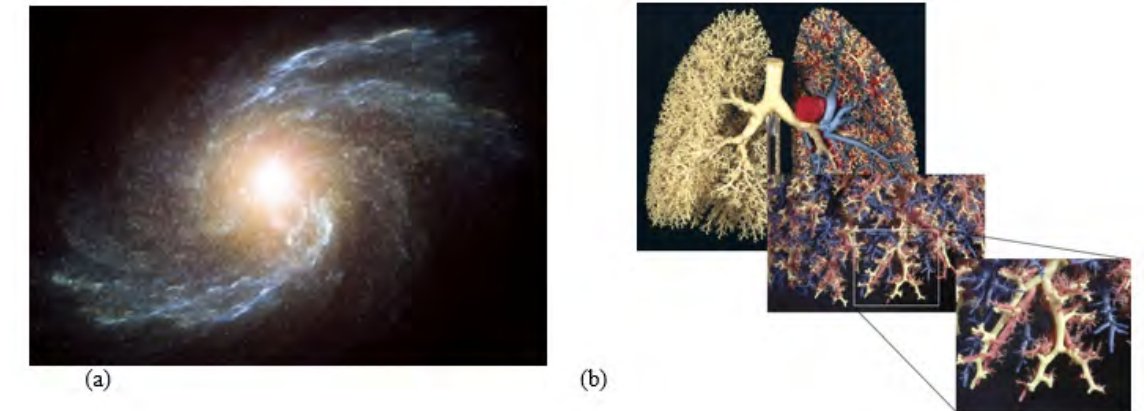
Figure 2. (a) Spiral galaxy; (b) mammalian